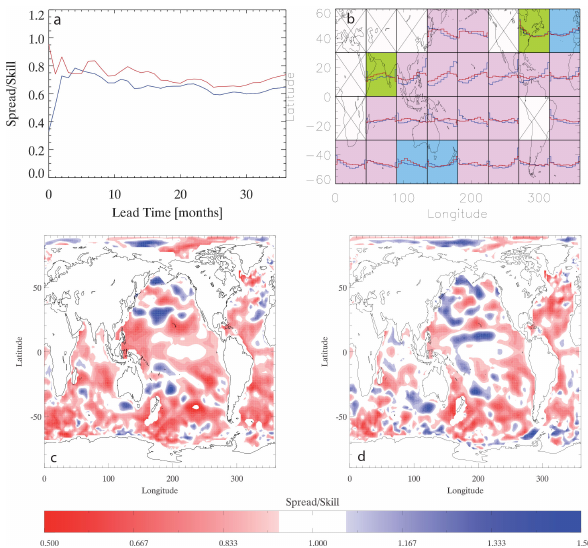
Fig. 6. Spread–skill scores (a, c, d) and Talagrand diagram (b) for 1000–3500m temperature: (a) globally averaged spread–error ra- tios for the lagged (blue) and bred initialized ensemble (red), (b) Talagrand diagram (as in Fig. 4) for the lagged (blue) and bred (red) initialized ensembles for a lead time of one year; spread–error ratios for one-year lead time for the lagged initialized ensemble (c) , and the bred initialized ensemble (d) .